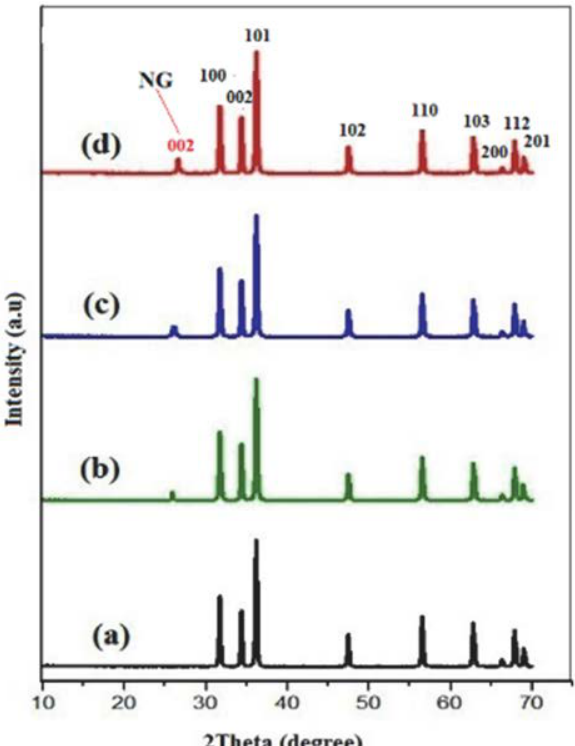
Figure 2. PXRD patterns of (a) ZnO (b) ZG-1 (c) ZG-2 (c) ZG-3 (d)